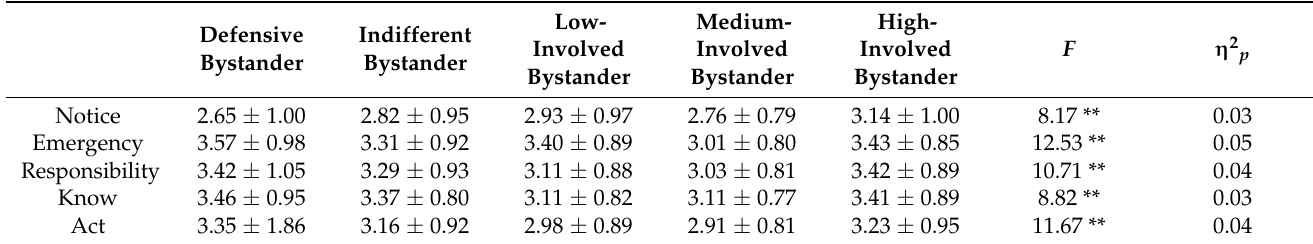
Table 2. Mean scores on bullying intervention as a function of the resulting latent classes.